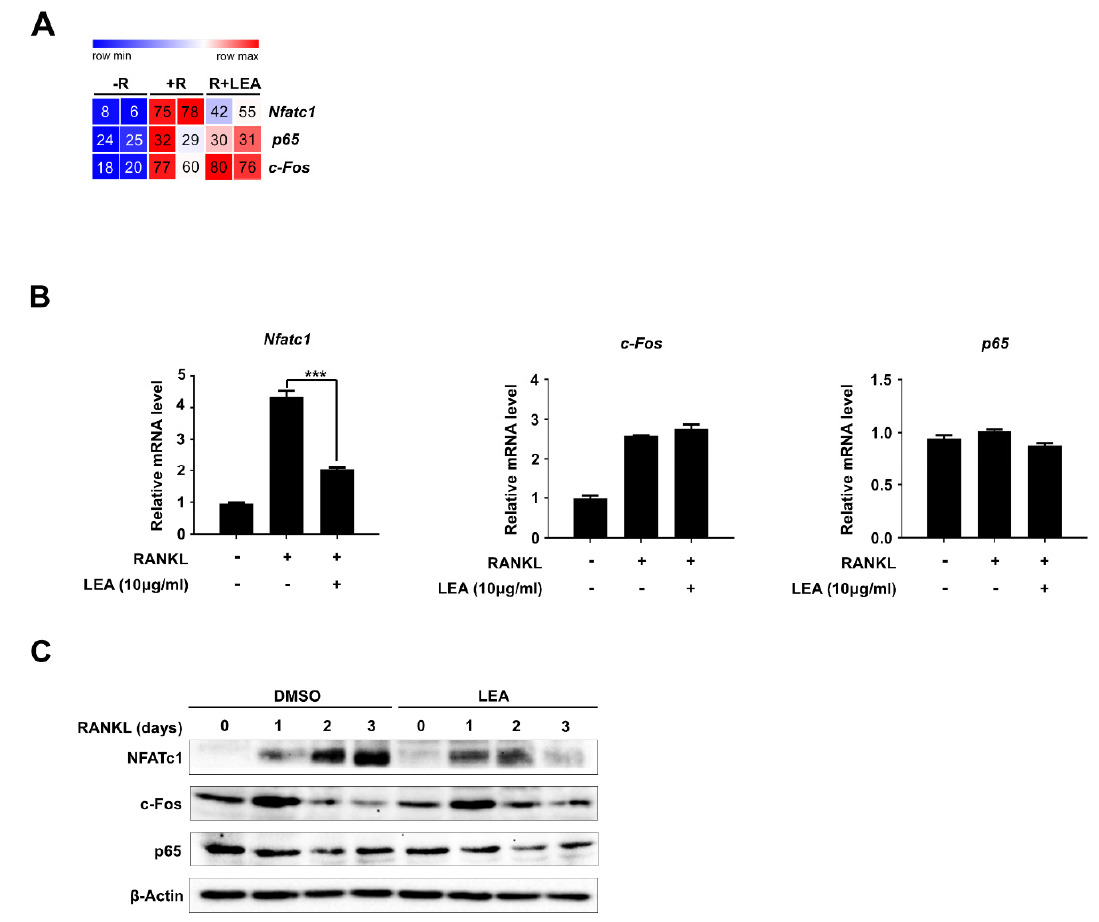
Figure 3. LEA represses RANKL-mediated NFATc1 expression. ( A ) Heatmap showing the reads per kilobase per million (RPKM) of c-Fos, NF- κ B and NFATc1. Numbers within the figure indicate